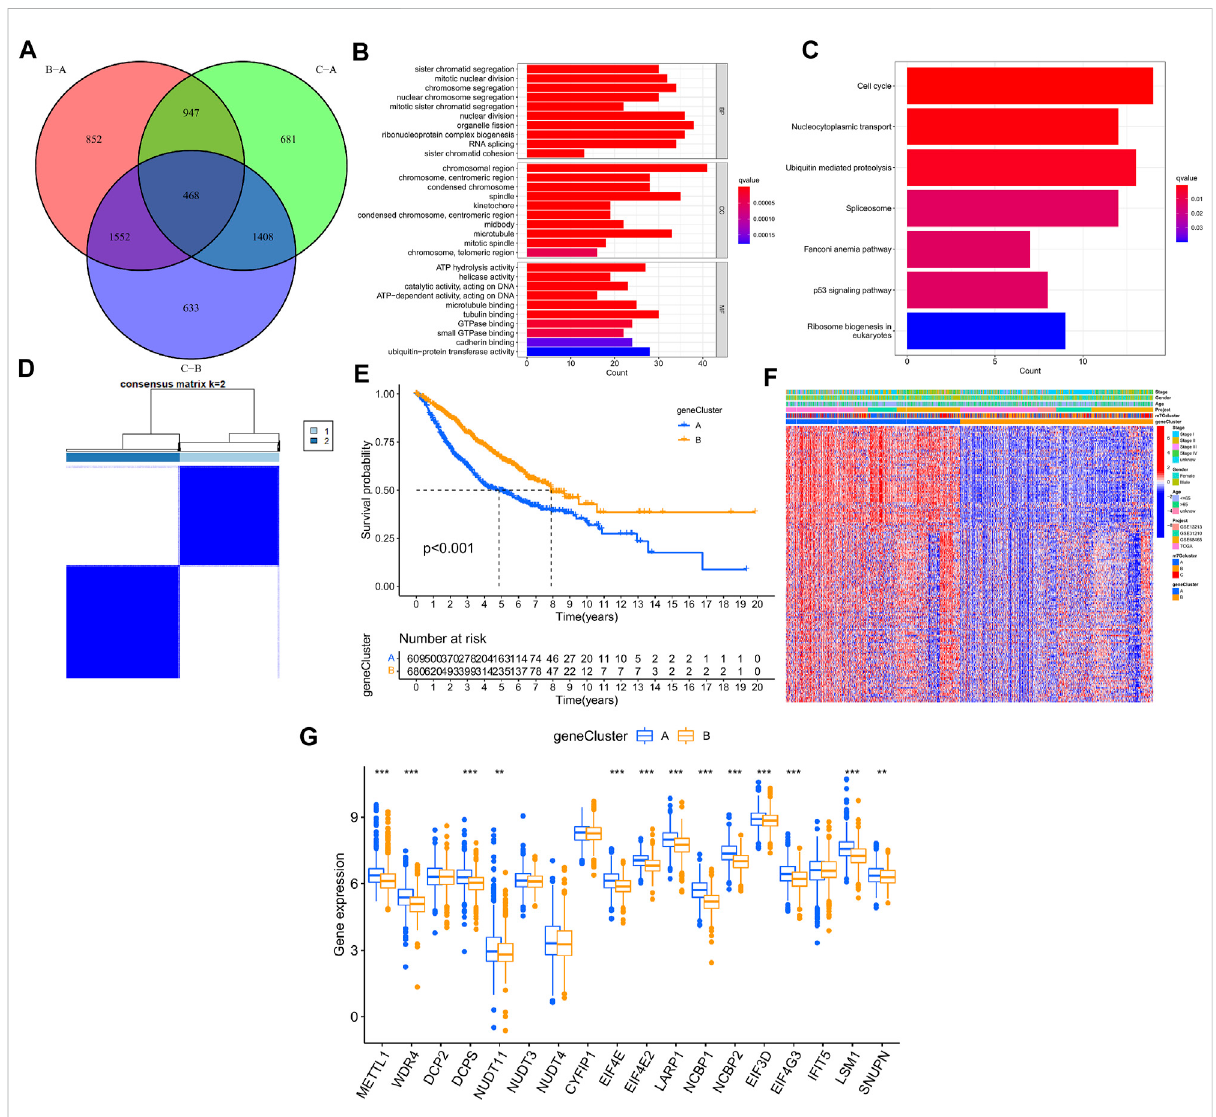
FIGURE 5 Genotyping based on m7G-associated DEGs in LUAD. (A) Venn diagram of DEGs from three LUAD m7G-Clusters. (B – C) GO and KEGG enrichment analysis for the 468 DEGs. (D) Consensus clustering was used to divide the LUAD patients into 2 gene clusters. (E) Kaplan – Meier OS curves of patients in the 2 gene clusters. (F) Clinical pathological features of the 2 gene clusters. (G) Expression of m7G-associated genes between the 2 gene